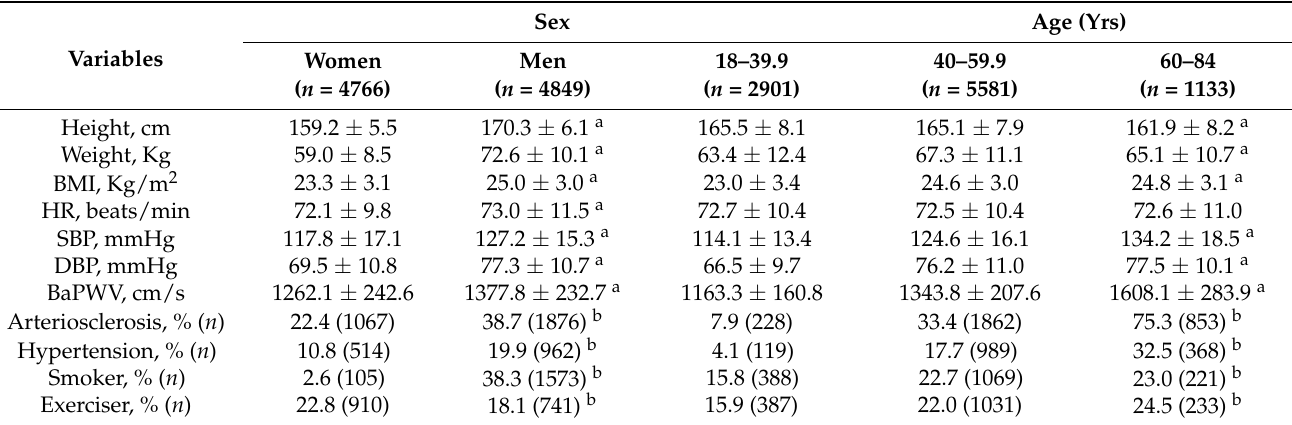
Table 1. Baseline characteristics by sex and age in the